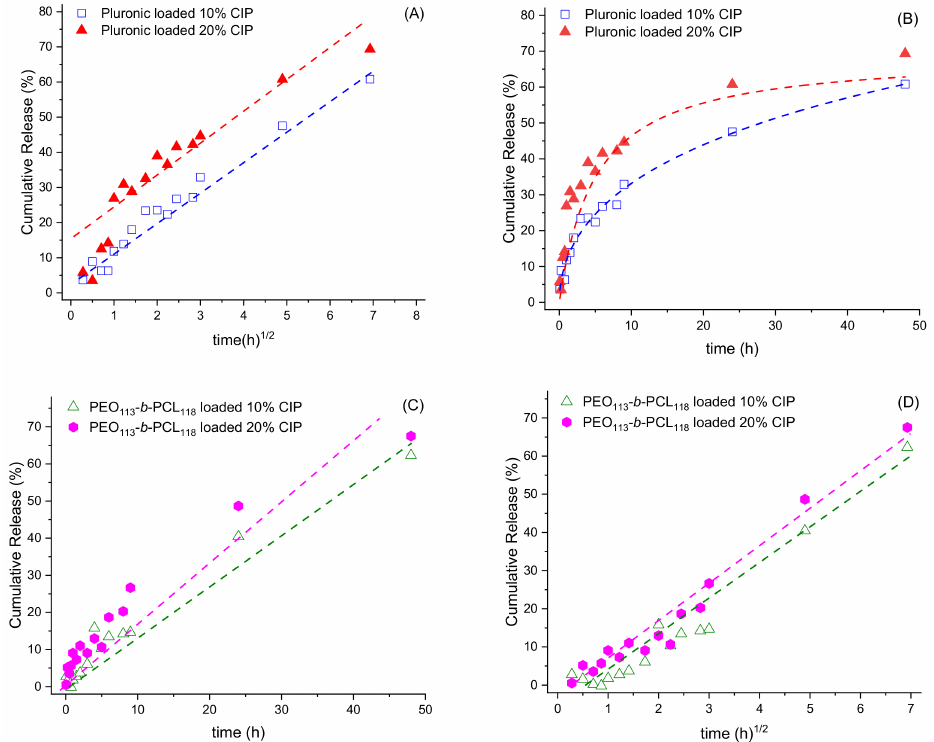
Figure 7. Model fitting using Higuchi ( A , D ), Korsmeyer–Peppas ( B ), and zero-order ( C ) approaches